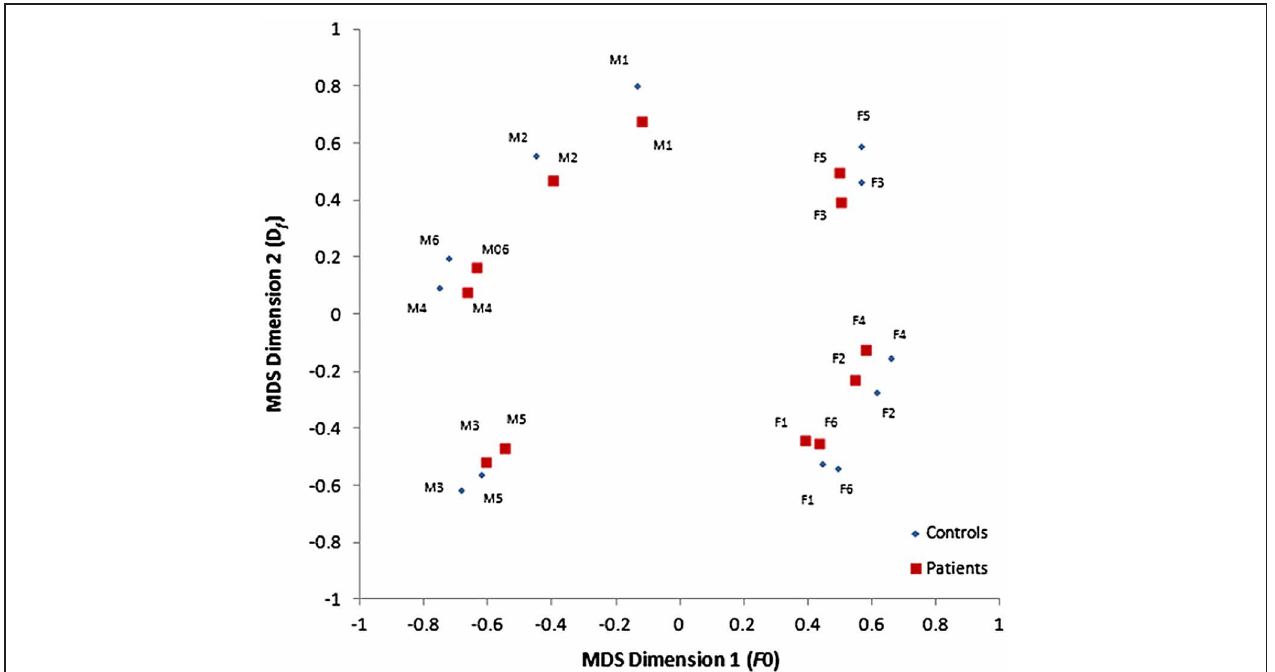
Voices that appear more widely separated in this voice space are perceived as more different than those closer together. [Reprinted from Chhabra et al. (2012a) with permission from Elsevier]. Note: M , male voices; F , female voices.